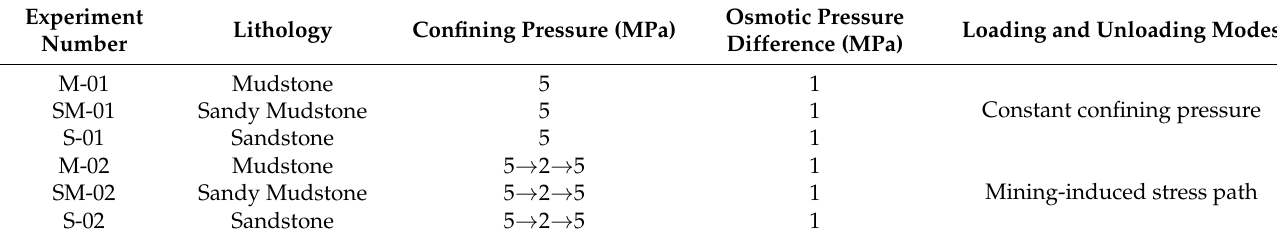
Table 1. Rock specimen information and test